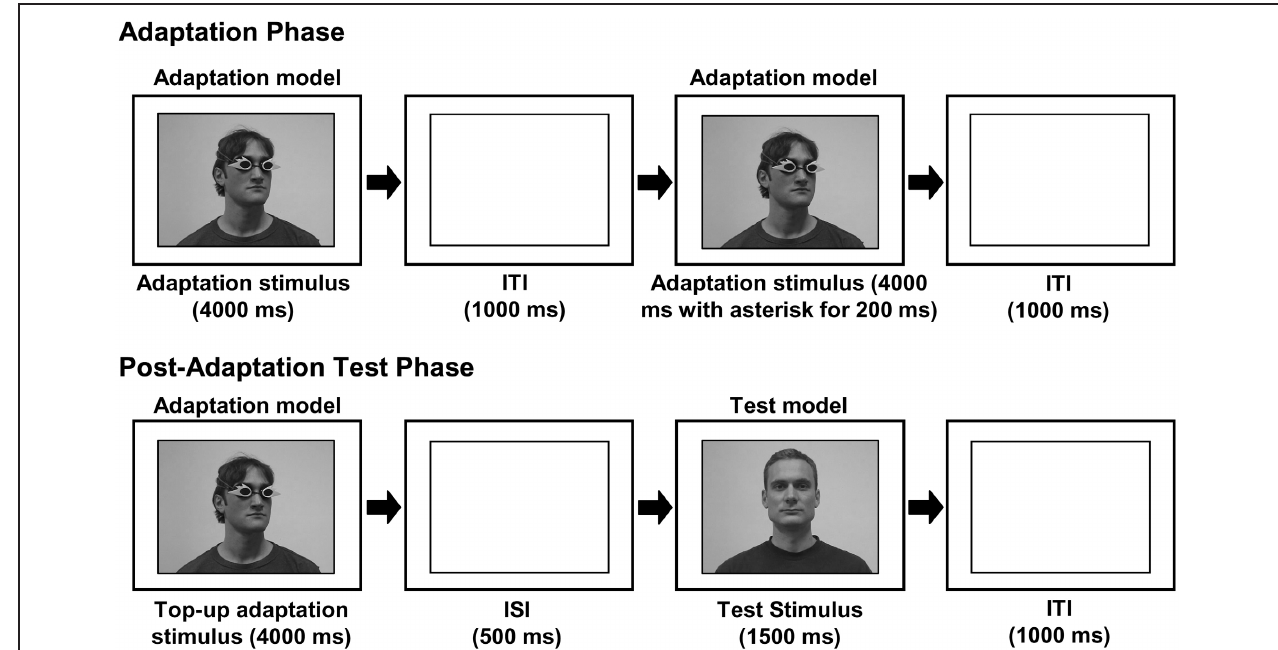
(as indicated by head-orientation). This adaptation block was then followed by a post-adaptation test, in which observers’ gaze-perception was measured. Each post-adaptation test trial consisted of a test stimulus gazing to the left, straight ahead, or to the right, preceded by a top–up adaptation